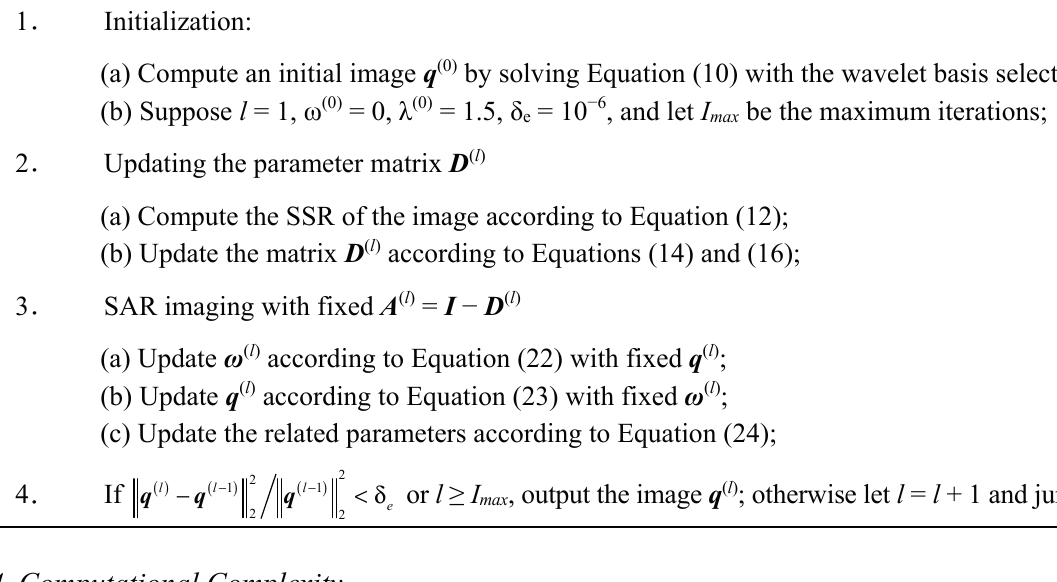
Table 1. The proposed ASR-CS-SAR